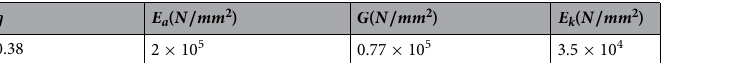
Table 3. Calculation parameters. η friction coefficient of the anchor, E a elastic modulus of the anchor, G shear modulus of the anchor, E k elastic modulus of the frame column.